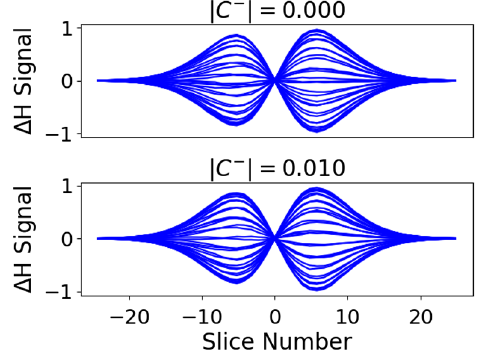
¼ 0 A for the oct